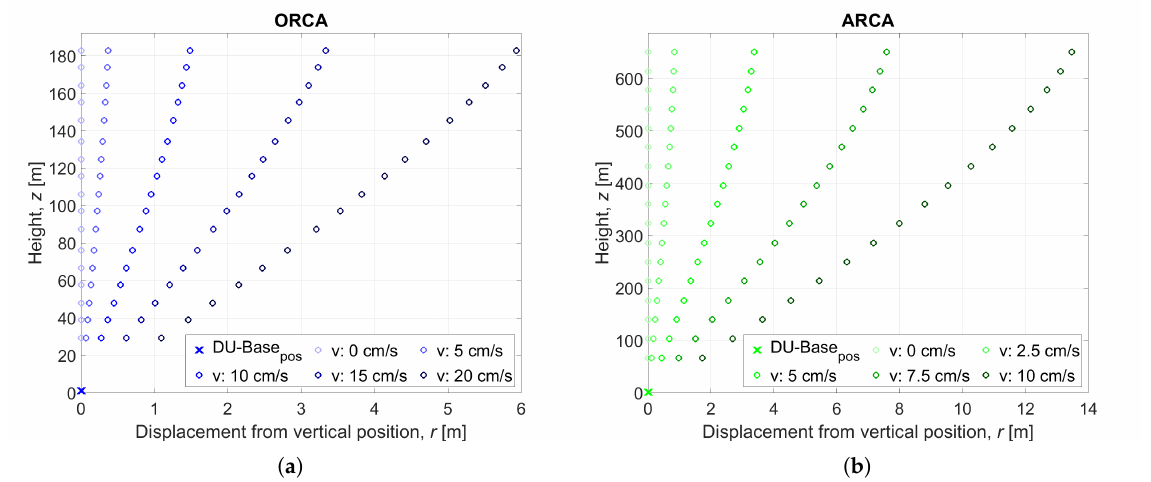
Figure 5. Mechanical model (MM) application to line shape in KM3NeT. ( a ) Line shape in ORCA for different sea currents values. ( b ) Line shape in ARCA for different sea current